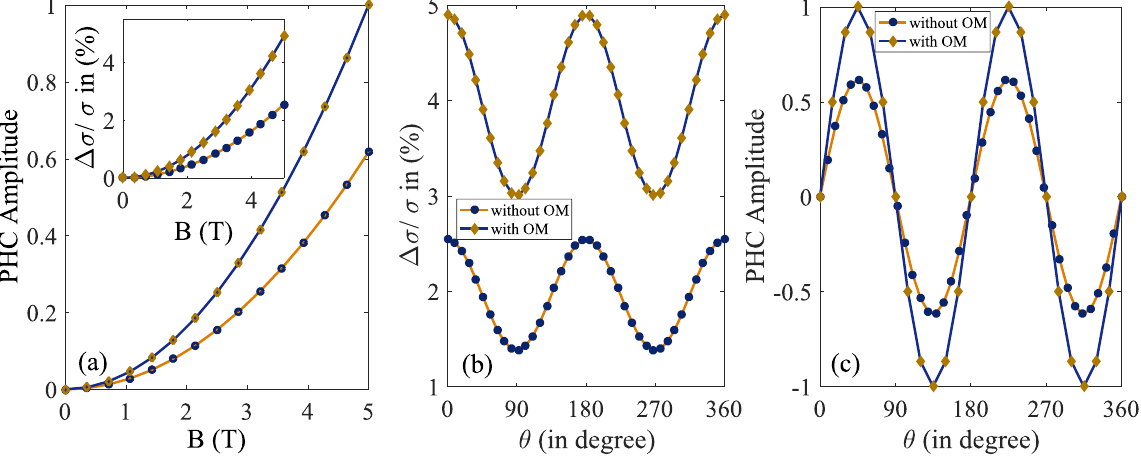
Figure 3. ( a ) Shows the dependence of amplitude of PHC (normalized by the maximum value of PHC in the presence of m ) as a function of in-plane magnetic field at θ = π /4 and temperature T = 24 K. (Inset depicts the LMC in the presence as well as absence of orbital magnetic moment ( m ) as a function of in-plane magnetic field at θ = 0°. The other parameters are same as above). ( b , c ) Show the angular dependence of LMC and PHC (normalized) at T = 24 K in the presence and absence of m for B = 5 T. Here we have normalized the y axis of ( c ) by the value of PHC at θ = π /4 in the presence of m . Curves in yellow indicate the presence of m whereas blue lines are for m = 0. In all cases we consider the Fermi level situated at 27 meV from the bottom of the lowest conduction